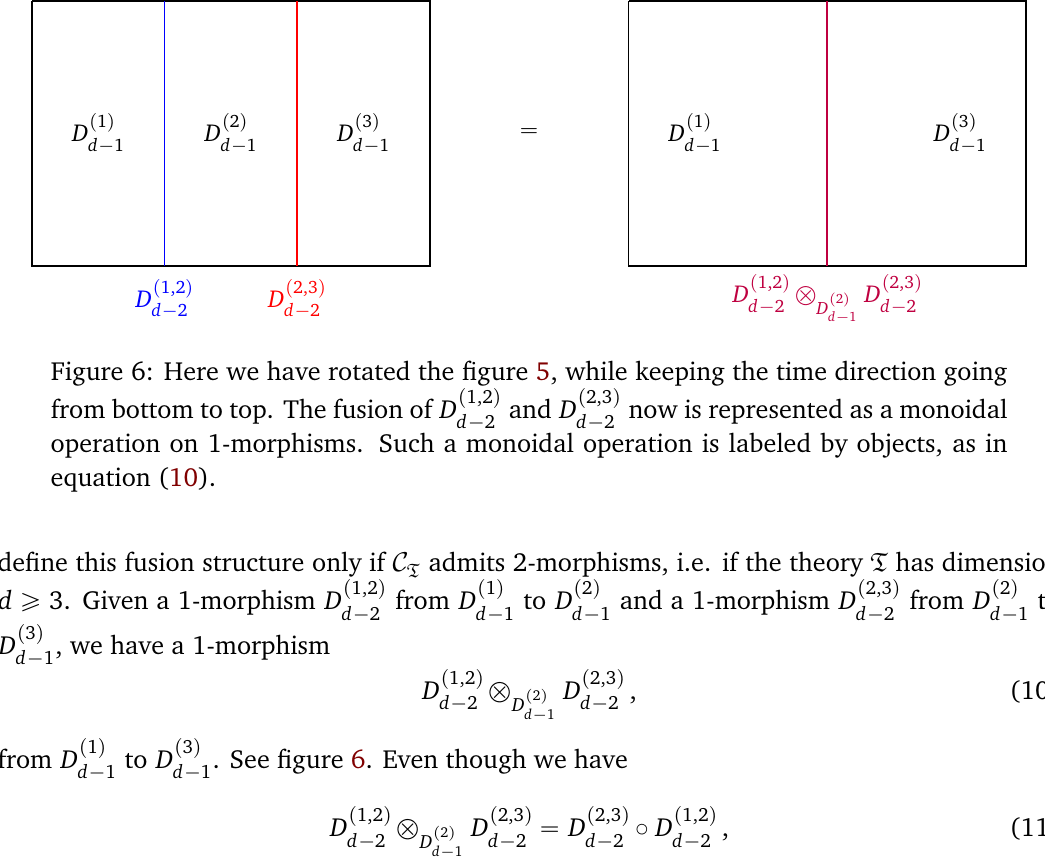
Figure 5: Fusing two codimension-2 defects D p 1,2 q ˝ D p 1,2 q D p 2,3 q . d ´ 2 d ´ 2